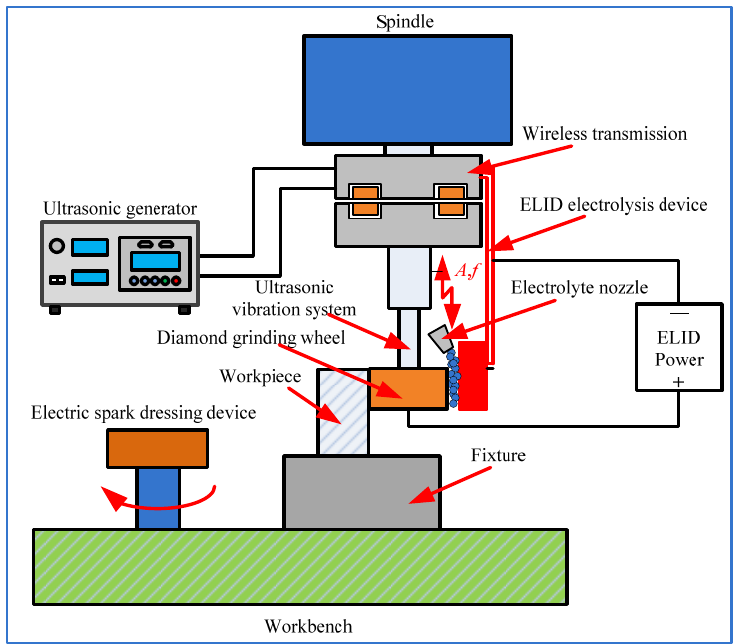
Figure 1. Schematic of UA-ELID grinding.